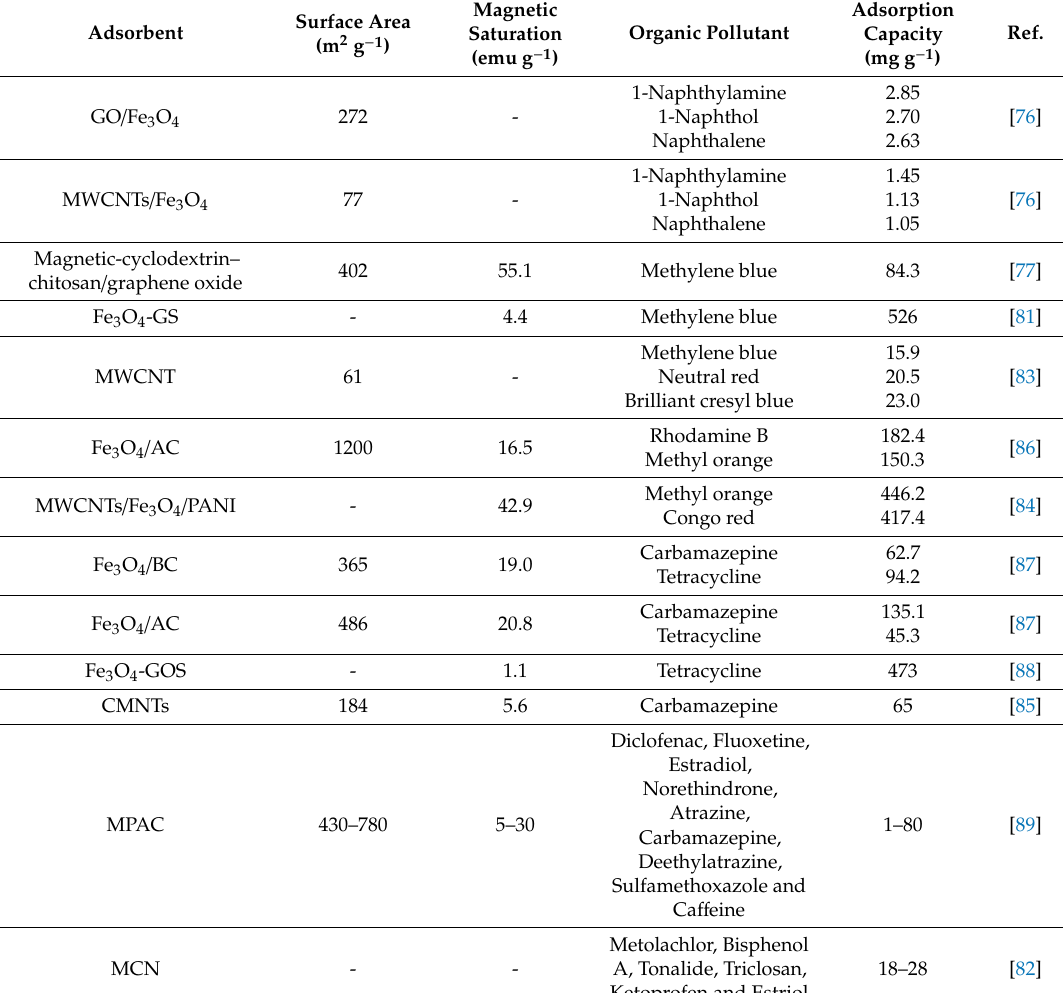
Table 3. Application of magnetic carbon-based nanoadsorbents for organic pollutant removal from